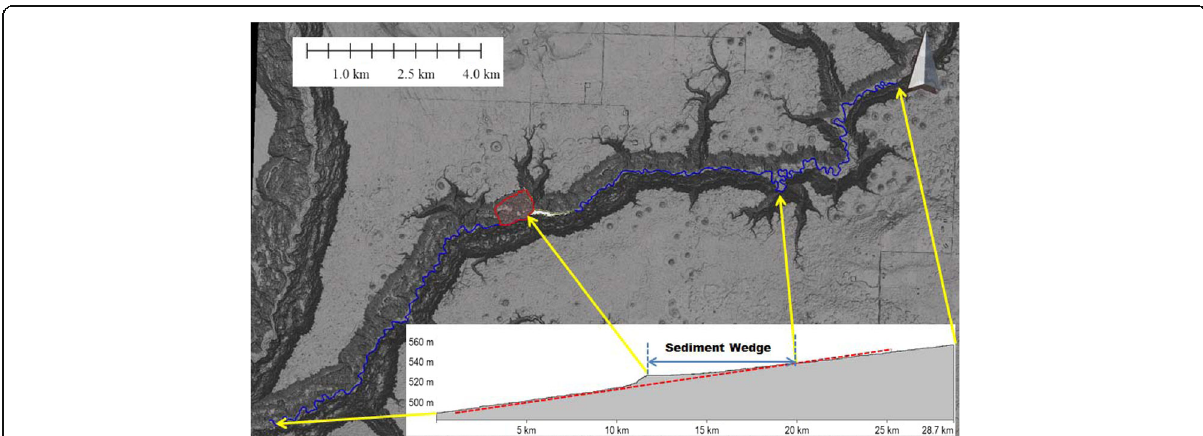
Fig. 6 Plan view and channel longitudinal profile of the lower Eureka River, generated from lidar data (dated September 26, 2013; source: Government of Alberta, reproduced with permission). The red line (cross-section) roughly follows the longitudinal profile of the lower Eureka River (below the landslide). The grey area situated above red line indicates areas of lacustrine and deltaic sedimentation upstream of the landslide dam